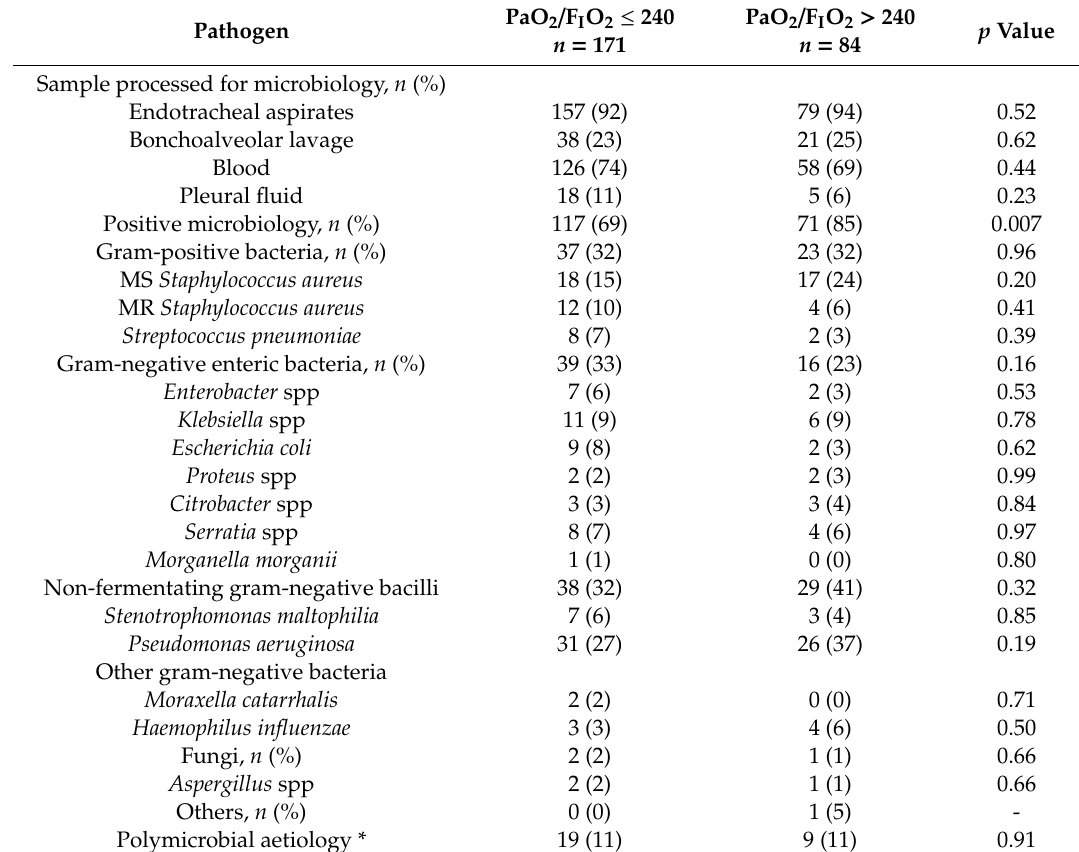
Table 3. Etiologic diagnosis of pneumonia according to PaO 2 / F I O 2.